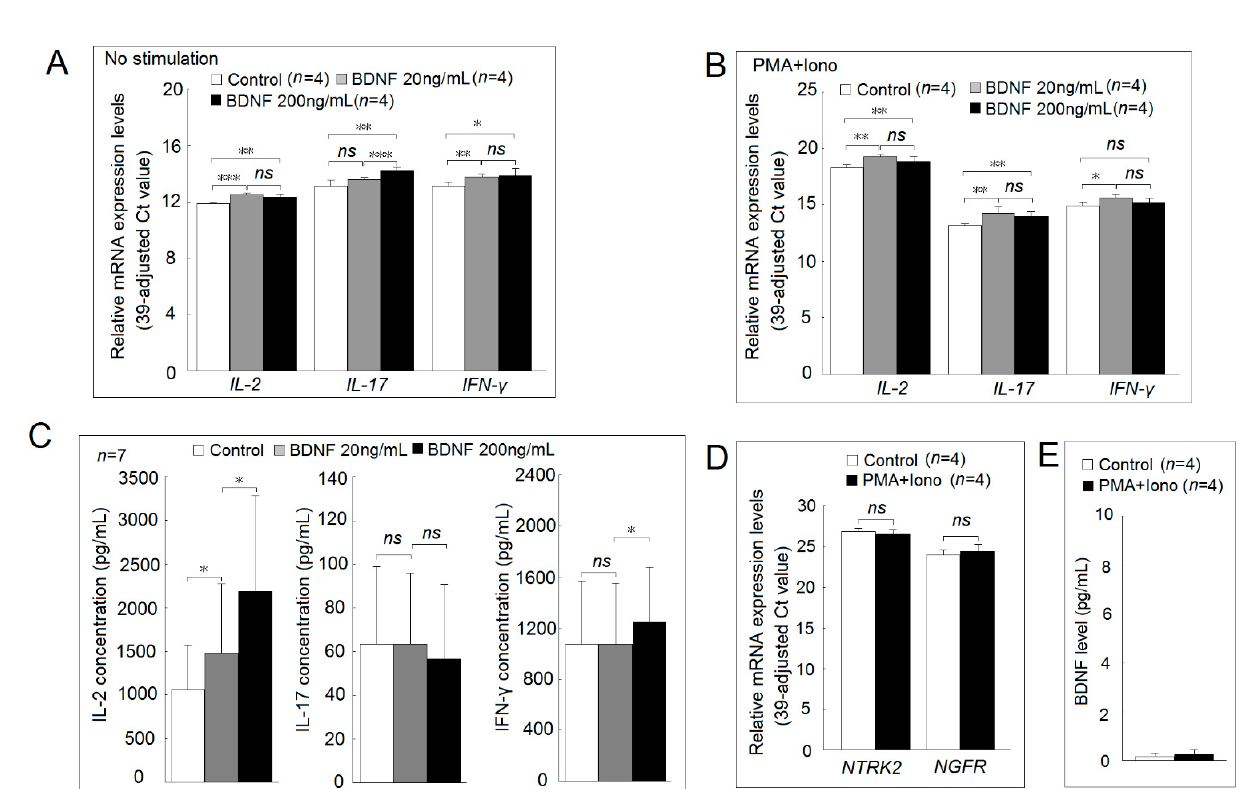
Figure 5. Functional studies of BDNF and its receptors in Jurkat cells and normal peripheral blood mononuclear cells (PBMCs). ( A ) The mRNA expression of IL-2 , IL-17 and IFN- γ in Jurkat cells with BDNF (0, 20 or 200 ng/mL) for 4 hours. ( B ) The mRNA expression of IL-2 , IL-17 , and IFN- γ in Jurkat stimulated with phorbol 12-myristate 13-acetate (PMA; 20 ng/mL) + ionomycin (Iono; 1000 ng/mL) plus BDNF (0, 20 or 200 ng/mL) for 4 h. ( C ) Normal PBMCs (1 × 10 6 /mL) were stimulated with 1 µ g/mL anti-human CD3 and 1 µ g/mL anti-human CD28 plus different concentrations of BDNF (0, 20 or 200 ng/mL) for 24 hours. ( D ) The mRNA expression of NTRK2 and NGFR in Jurkat cells after stimulated with PMA and ionomycin for 4 hours. ( E ) The concentration of BDNF in culture soup of Jurkat cells after cocultured with culture medium or PMA (20 ng/mL) + Iono (1000 ng/mL) for 24 hours ( ns , not significant; * p < 0.05; ** p < 0.01; *** p < 0.001).